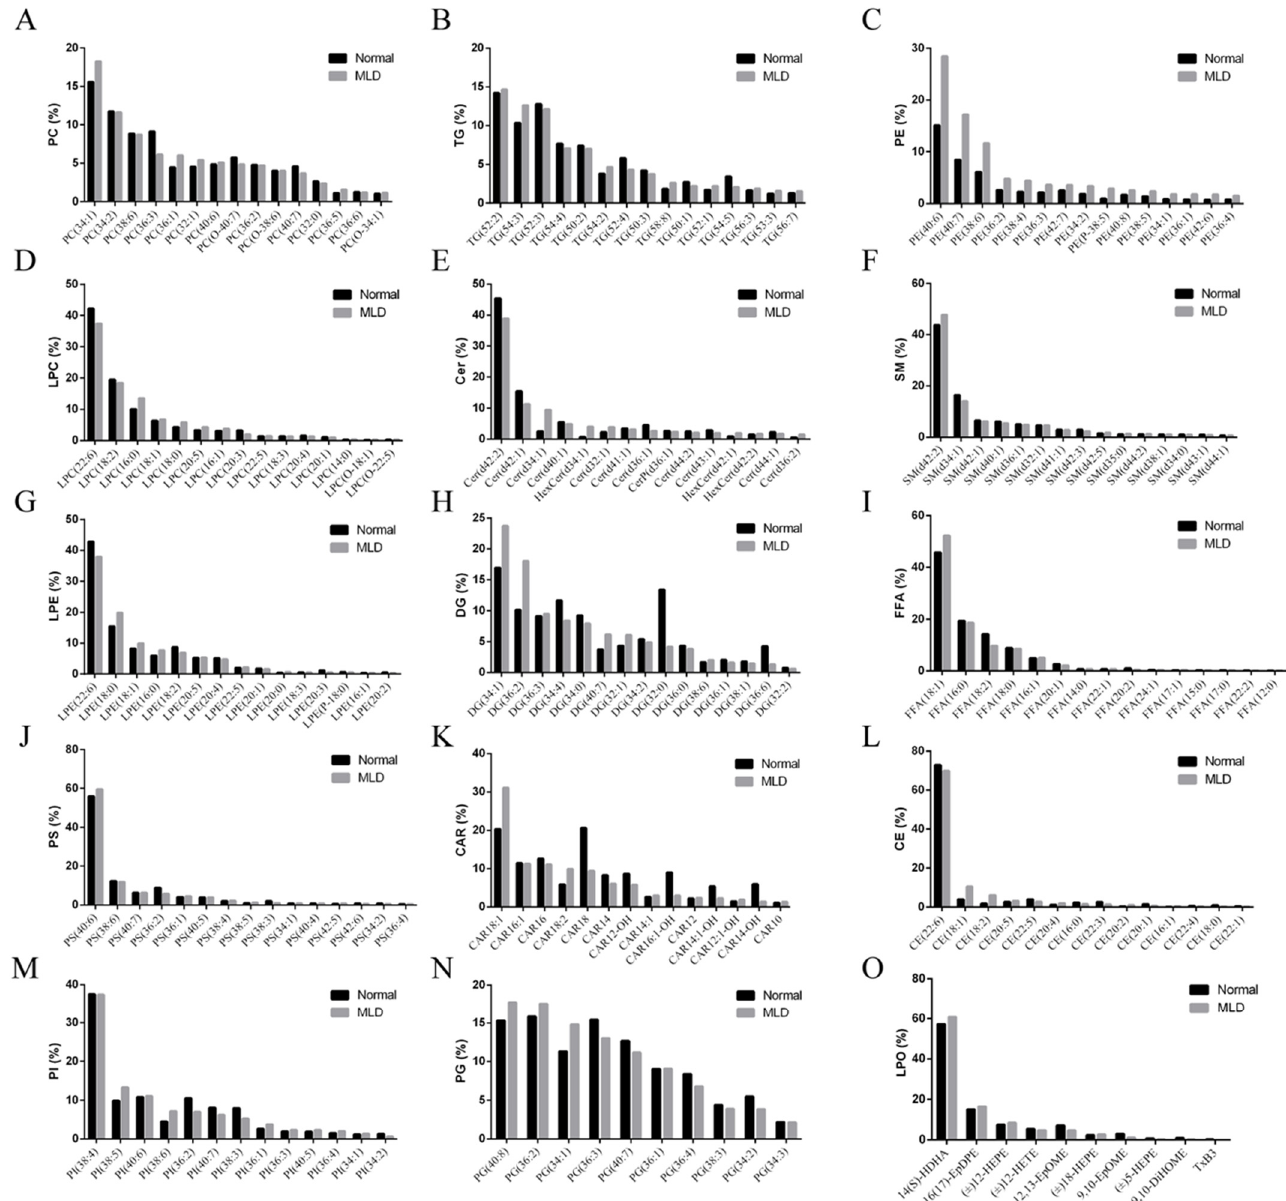
Figure 3. Major lipid in the liver of largemouth bass (Mean ± SEM, n = 8). ( A ) PC: phosphatidylcholine. ( B ) TG: triacylglycerol. ( C ) PE: phosphatidylethanolamine. ( D ) LPC: lysophosphatidyl choline. ( E ) Cer: ceramide. ( F ) SM: sphingomyelin. ( G ) LPE: lysophosphatidylethanolamine. ( H ) DG: diacylglycerol. ( I ) FFA: free fatty acid. ( J ) PS: phosphatidylserine. ( K ) CAR: acyl carnitine. ( L ) CE: cholesteryl ester. ( M ) PI: phosphatidylinositol. ( N ) PG: phosphatidyl glycerol. ( O ) LPO: lipid